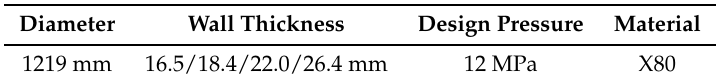
Table 2. The basic parameters of the pipeline.